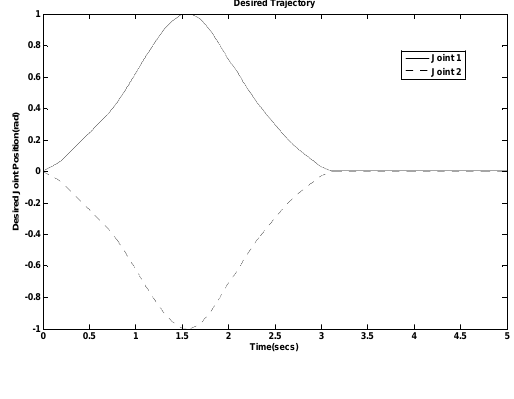
Fig. 7. Desired position